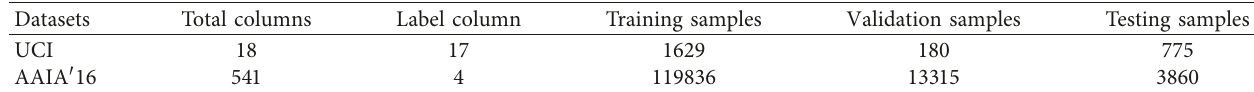
Table 1: Experimental datasets.